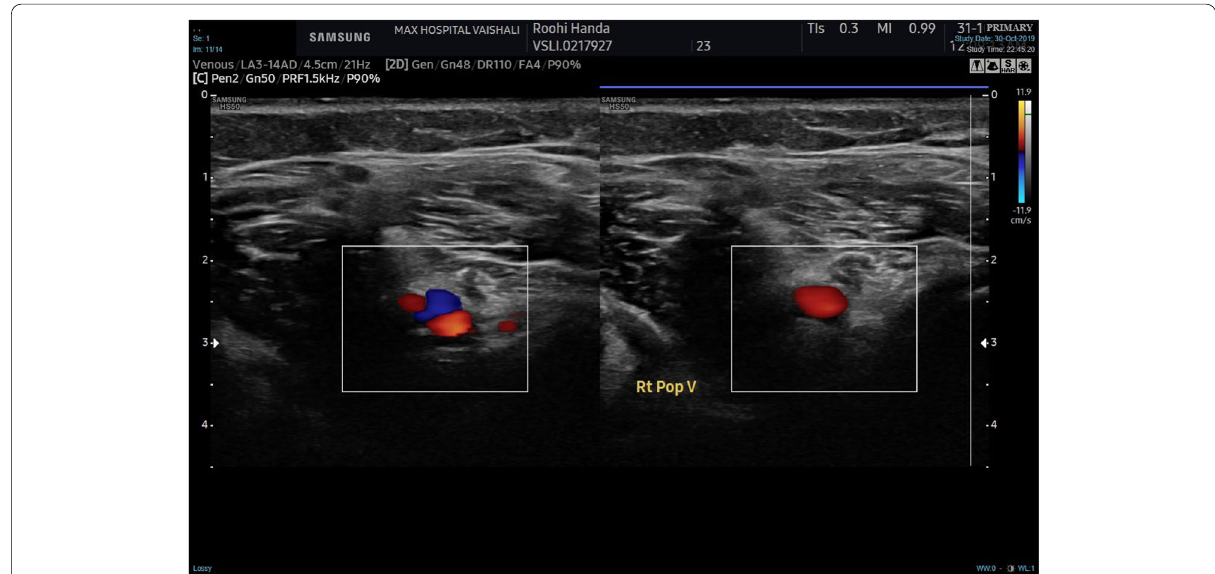
Fig. 7 Venous Doppler of the lower limb revealed deep vein thrombosis involving right popliteal veins with extension into short saphenous vein